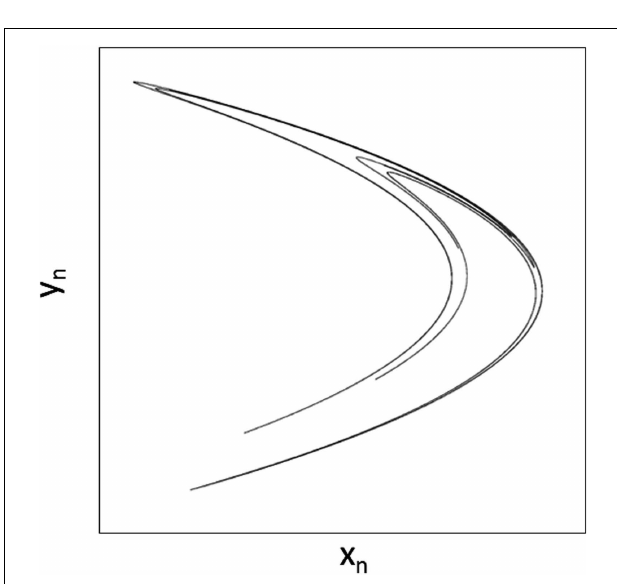
It is very instructive to study the dynamics of the Hénon attrac- torbyfollowingthetimecoursesof x , y individuallyandcoupledin both the chaotic and periodic modes of the system. To get started, hints can be gleaned from Webber and Zbilut